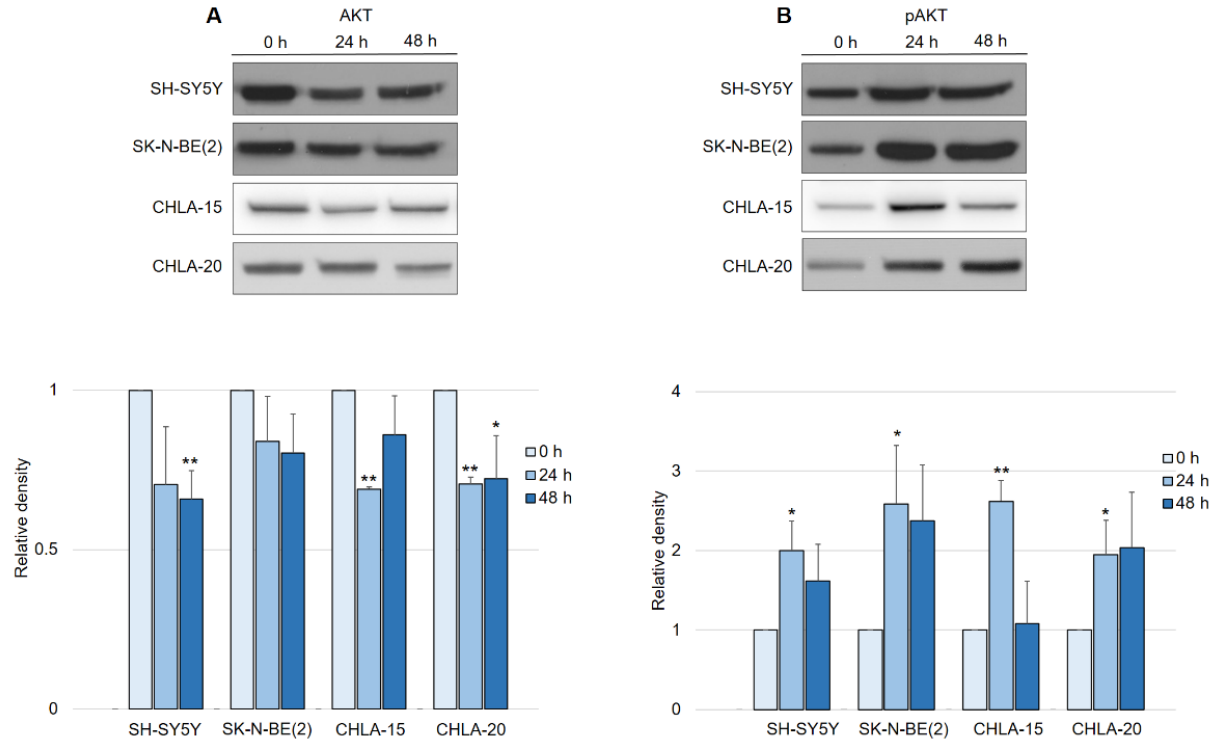
Figure 6. DpC regulates total and phosphorylated AKT protein levels in neuroblastoma cell lines. ( A ) Immunoblotting of AKT and ( B ) immunoblotting of pAKT (S473) protein levels in neuroblastoma cells treated with 20 µ M (SH-SY5Y, SK-N-BE(2)) or 2 µ M (CHLA-15, CHLA-20) DpC. Representative images ( up ) and relative optical density values ( down ) of three independent experiments. Source data are provided in Figure S1. Densitometry data are shown as the mean ± SD normalized to 0 h values. * p < 0.05; ** p < 0.01; two-tailed unpaired t -test.